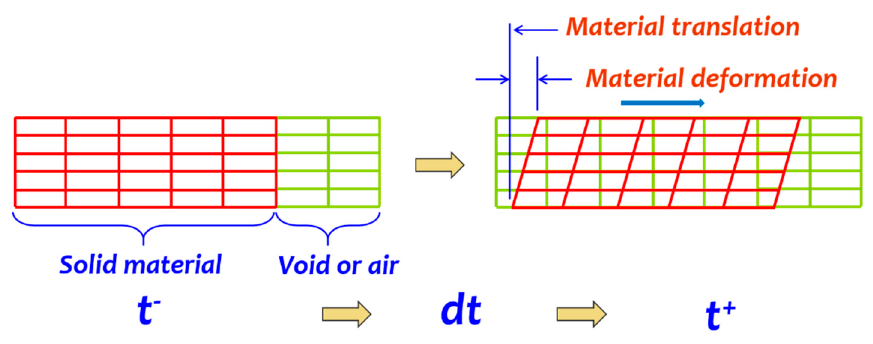
Figure 6. Solid material deforms and translates inside the fixed mesh, reproduced from reference [50] with permission from author.